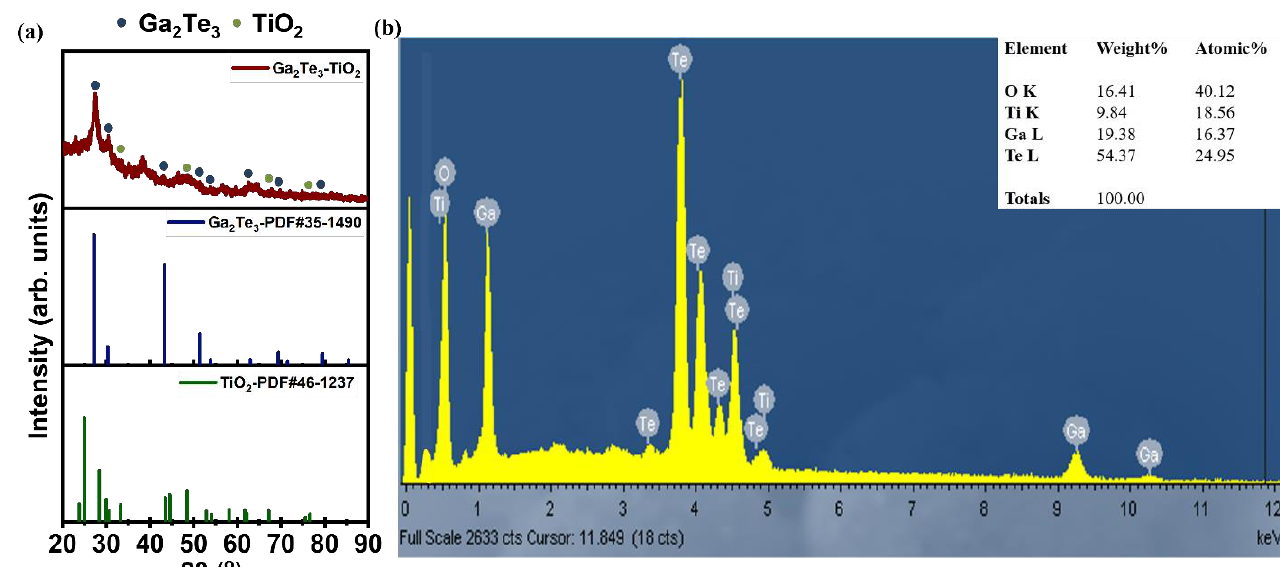
Figure 1. ( a ) XRD pattern of Ga 2 Te 3 – TiO 2 ; ( b ) EDX spectrum of Ga 2 Te 3 – TiO 2 . Morphological and structural analyses of Ga 2 Te 3 –TiO 2 –C(10%) were conducted, in- cluding SEM, HRTEM, and EDXS, as indicated in Figure 2. According to SEM images (Figure 2a,b), the Ga 2 Te 3 –TiO 2 –C(10%) particle size ranged from sub-micrometers to a few micrometers. The HRTEM images (Figures 2c and S3) revealed crystalline lattice spacings of 0.340, 0.294, and 0.208 nm, which corresponded to the (111), (200), and (220) crystal planes of Ga 2 Te 3 , respectively, and 0.311 nm, which corresponded to the (002) plane of TiO 2 . Additionally, amorphous C, which was anticipated to serve as a buffering network for the active material, formed surrounding Ga 2 Te 3 and TiO 2 . The scanning transmission electron microscopy image with EDXS mapping analysis (Figures 2d and S4) showed a uniform distribution of each element (Ga, Te, Ti, O, and C) in the Ga 2 Te 3 –TiO 2 –C(10%). different content of C showed C concentrations almost identical to their theoretical